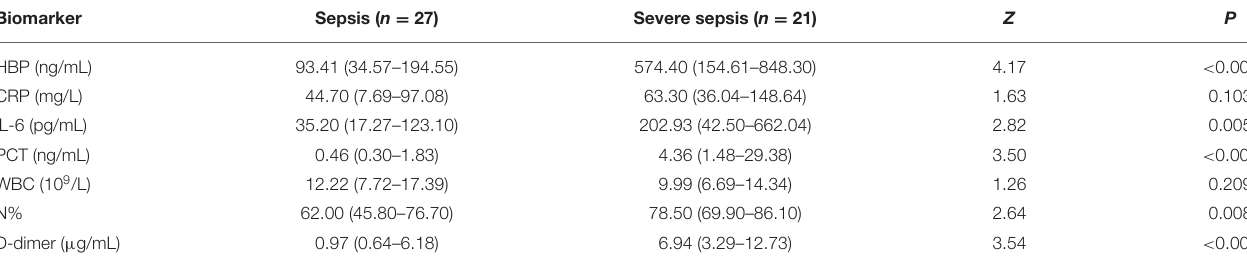
TABLE 4 | Biomarkers in children with sepsis or severe sepsis. Biomarker